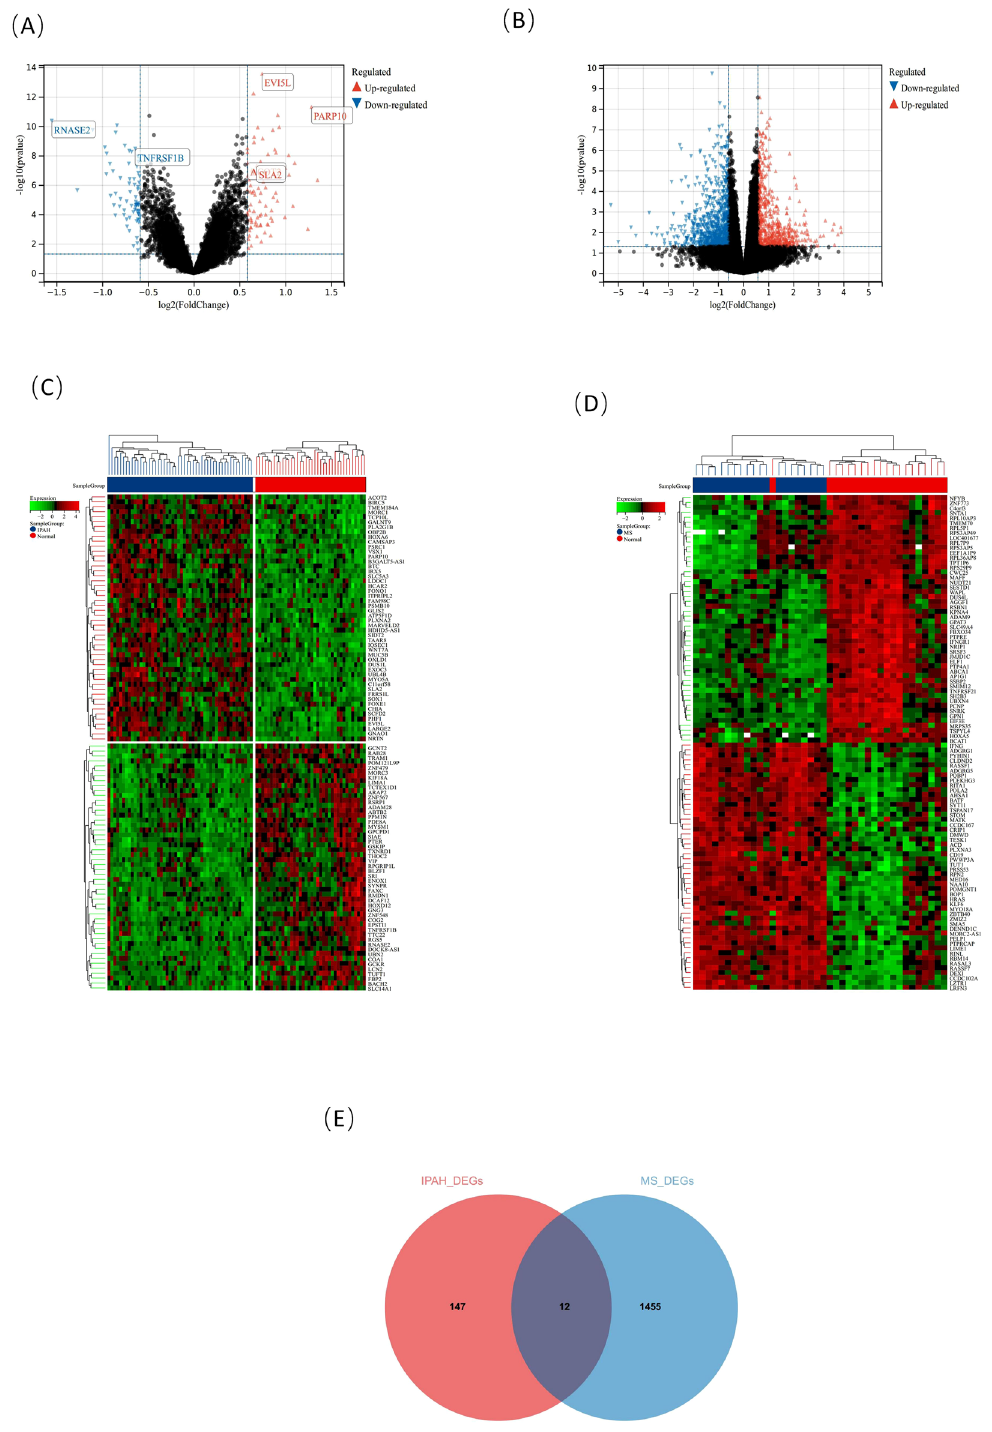
Figure 2. Volcano maps and heat maps of the IPAH and MS datasets. Drawn by R software program (version 3.40.6; R Foundation for Statistical Computing, Vienna, Austria, https:// www.r- proje ct. org/). ( A ) Volcano map of DEGs in IPAH dataset, |log2FC|> 0.5. ( B ) Volcano map of DEGs in MS dataset, |log2FC|> 0.5. Red represents up-regulated and blue represents down-regulated. ( C ) Heat map of DEGs in IPAH dataset. ( D ) Heat map of DEGs in MS dataset. Red and green indicate up-regulated and down-regulated DEGs, respectively. ( E ) Venn plot of overlapping IPAH and MS datasets